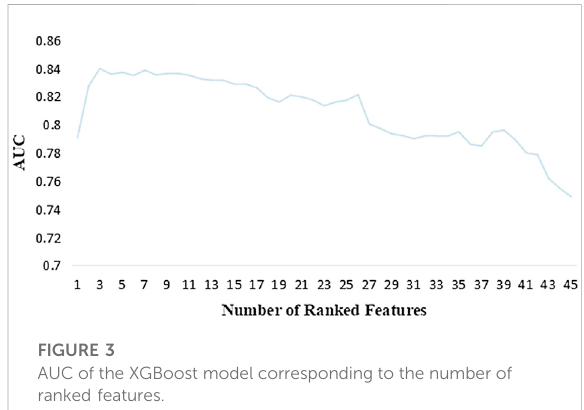
FIGURE 3 AUC of the XGBoost model corresponding to the number of ranked